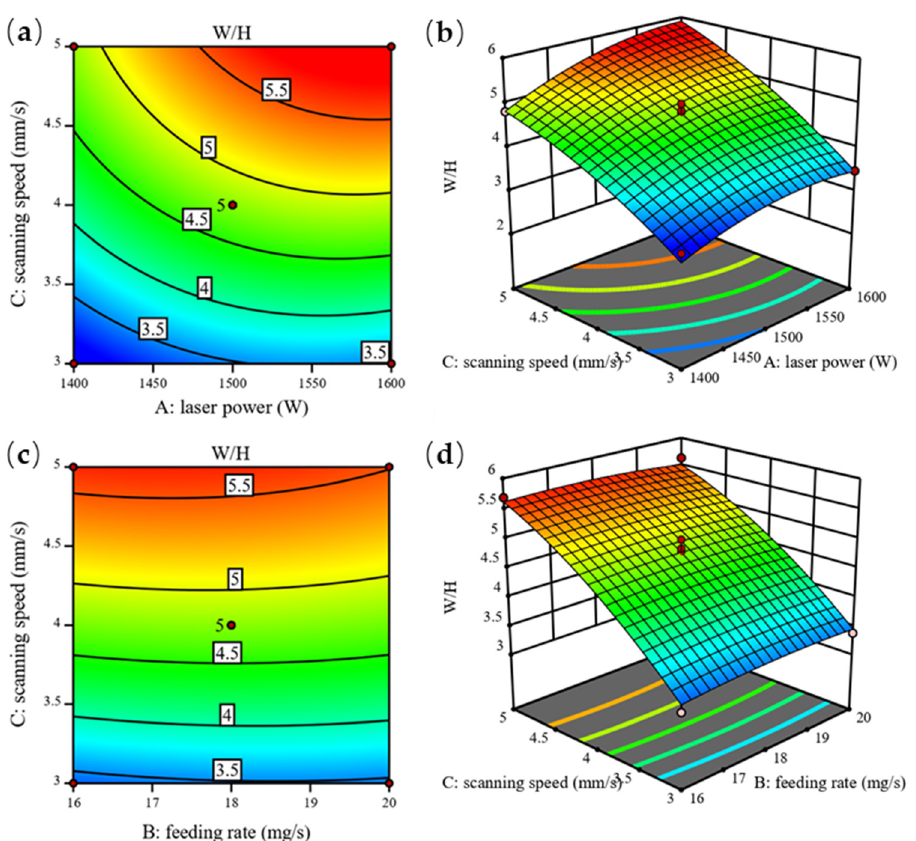
Figure 8. Contour line for effects of the interaction of ( a ) laser power and scanning speed and ( c ) powder feeding rate and scanning speed on the W/H. Impact of the correlation between ( b ) laser power and scanning speed and ( d ) powder feeding rate and scanning speed on the response surface of W/H.